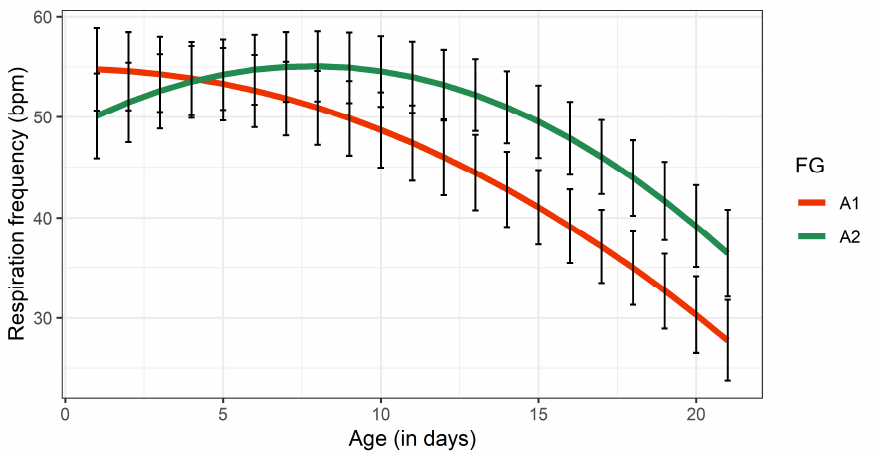
Figure 3. Least squares means for respiratory frequency of calves receiving either A1- or A2 milk during the experimental period of 21 days. Black bars indicate standard errors. FG, feeding